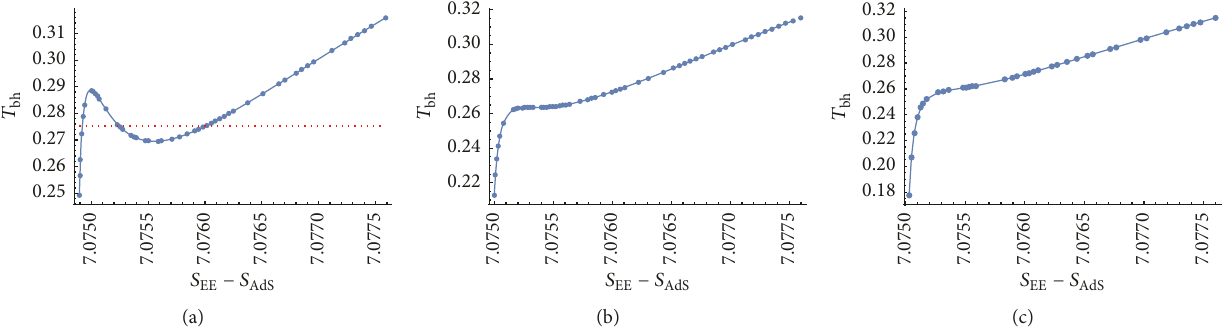
Figure 10: The figure shows 𝑇 versus 𝛿𝑆 for 𝛾 = −1, 𝜑 0 = 0.16 . Here 𝜆 = 2.4 , 𝑄 = 0.6𝑄 𝑐 , 𝑄 𝑐 , 1.2𝑄 𝑐 from (a) to (c).